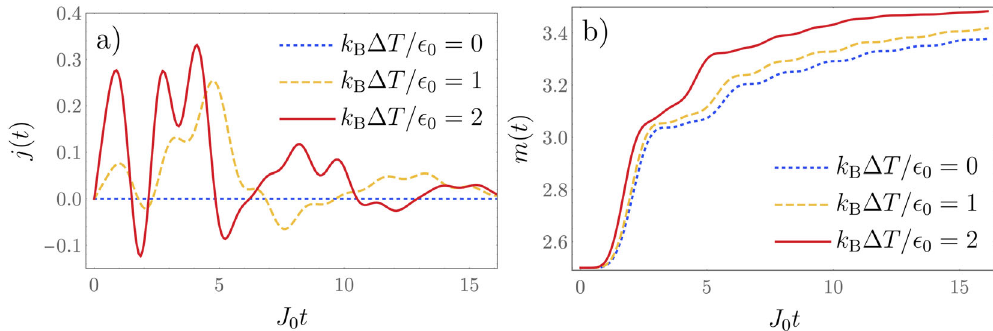
Fig. 5 Dynamics of spin currents and magnetization. Time evolution, according to Eq. (8), of a) the total spin current and b) the total magnetization with γ / J = 3.102 where J = α α fi cients at T = 0 and g is the interaction strength). In both panels k 0 0 1 / g ( 1 is the value of the exchange coef constant and ϵ 0 is the energy per particle in the thermodynamic limit. Curves show results for temperature gradients indicated in the legends. Our choice of the parameter γ (the rate at which spins are fl ipped at the edges) is arbitrary. It does not change the overall dynamics, but only the timescale for reaching equilibrium. All presented quantities are dimensionless.